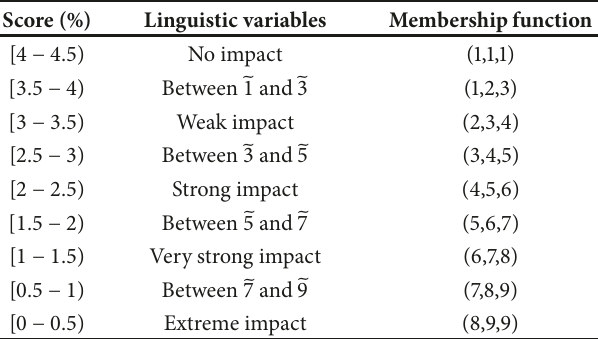
Table 4: Scores for the rate of regional per capita GDP of national per capita